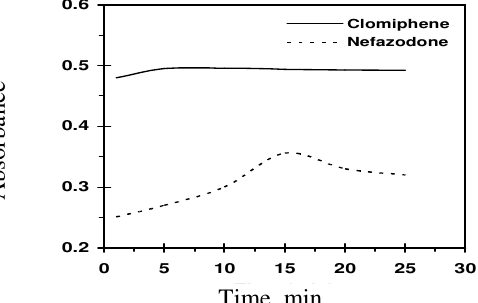
Figure 3. Effect of precipitation time on the absorbance of the complex formed through reaction of 1.2, 1.4 mg/mL clomiphene and nefazodone with ammonium